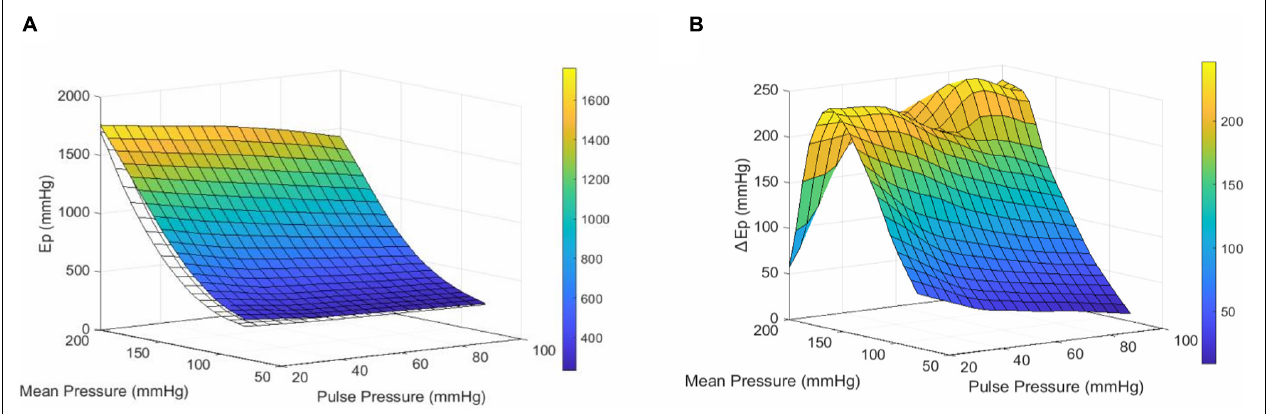
FIGURE 4 | Comparison of the stiffness-profile of the thoracic descending and abdominal infrarenal aorta. (A) Surface plot representing the mean Ep of the descending aorta (transparent/white) and the infrarenal aorta (colored) at different pulse & mean pressures. (B) Surface plot representing the mean difference in Ep ( (cid:49) EP) between the infrarenal and thoracic aorta for every pulse & mean pressure. Ep, Peterson’s modulus of elasticity; (cid:49) EP, EP infrarenalaorta –EP descendingaorta ; PP, pulse